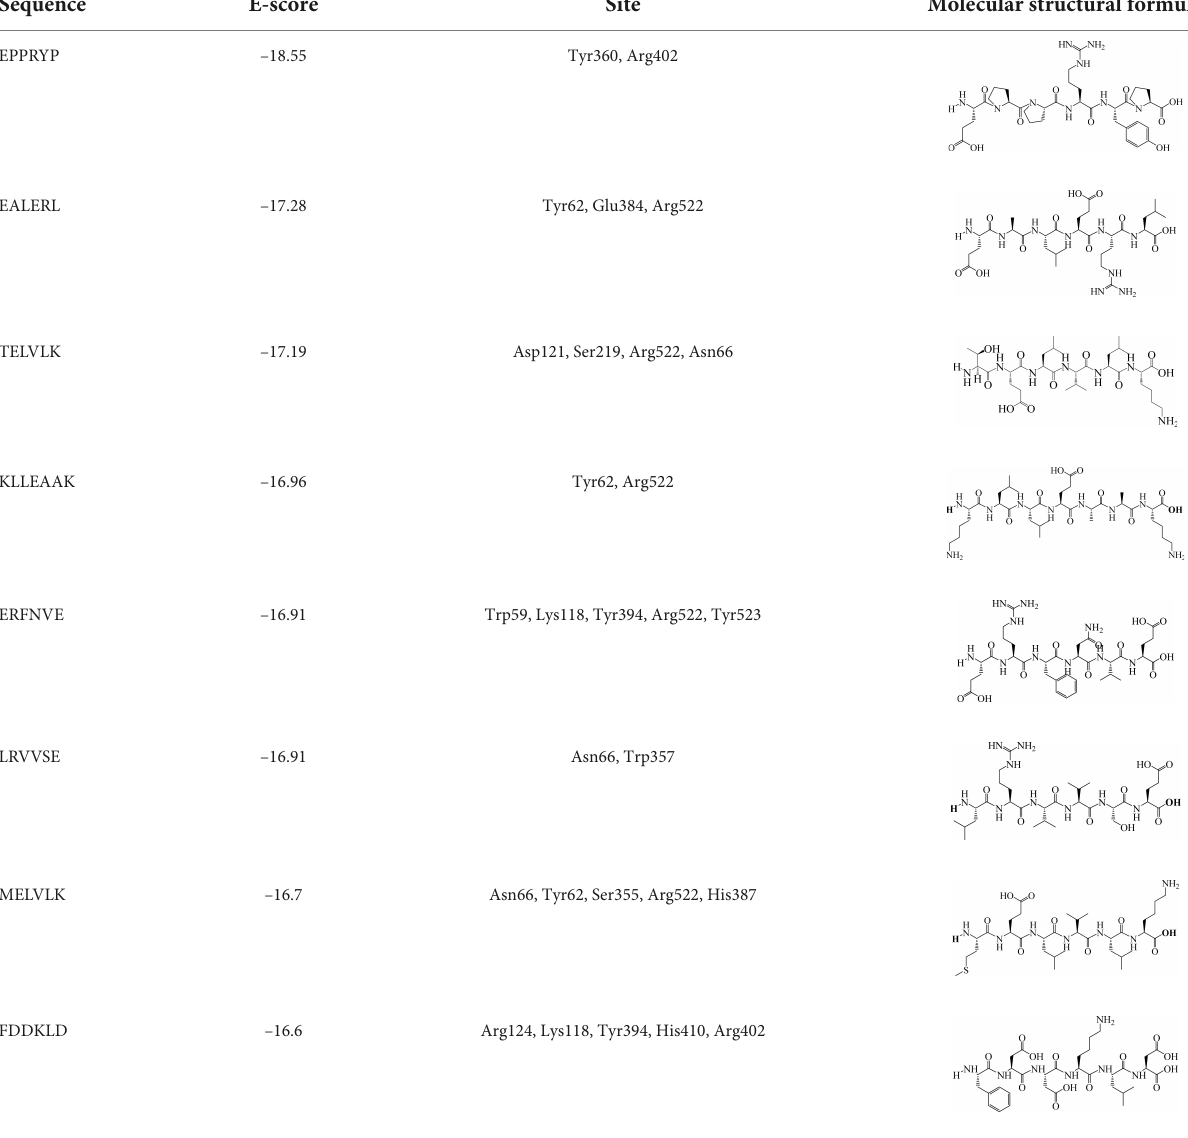
TABLE 6 Eight peptides and their binding